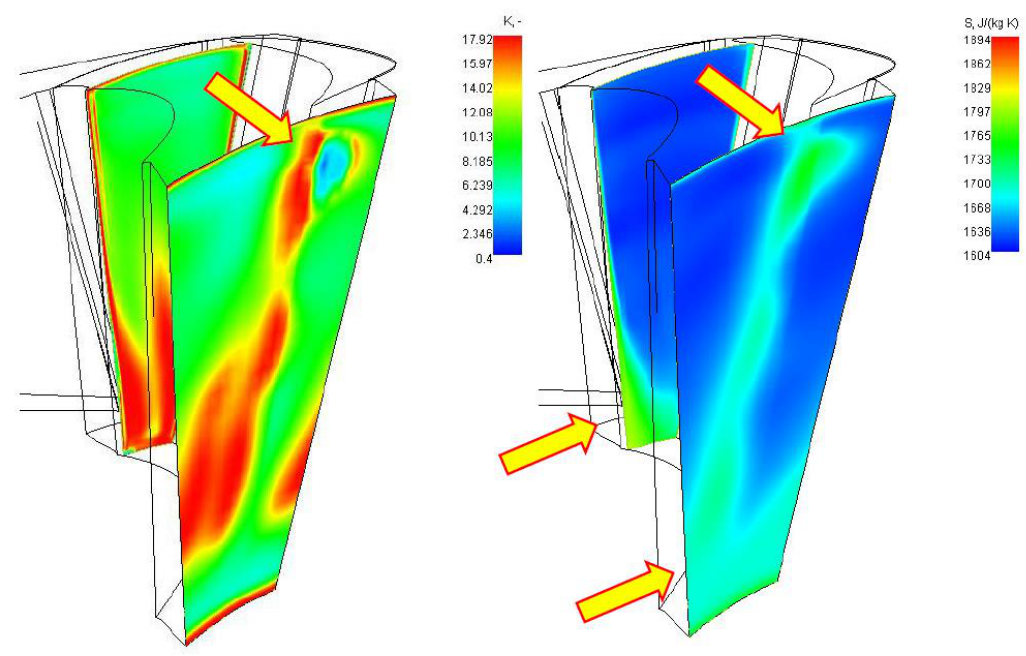
Figure 39. Turbulent kinetic energy and entropy streamwise section scenes.